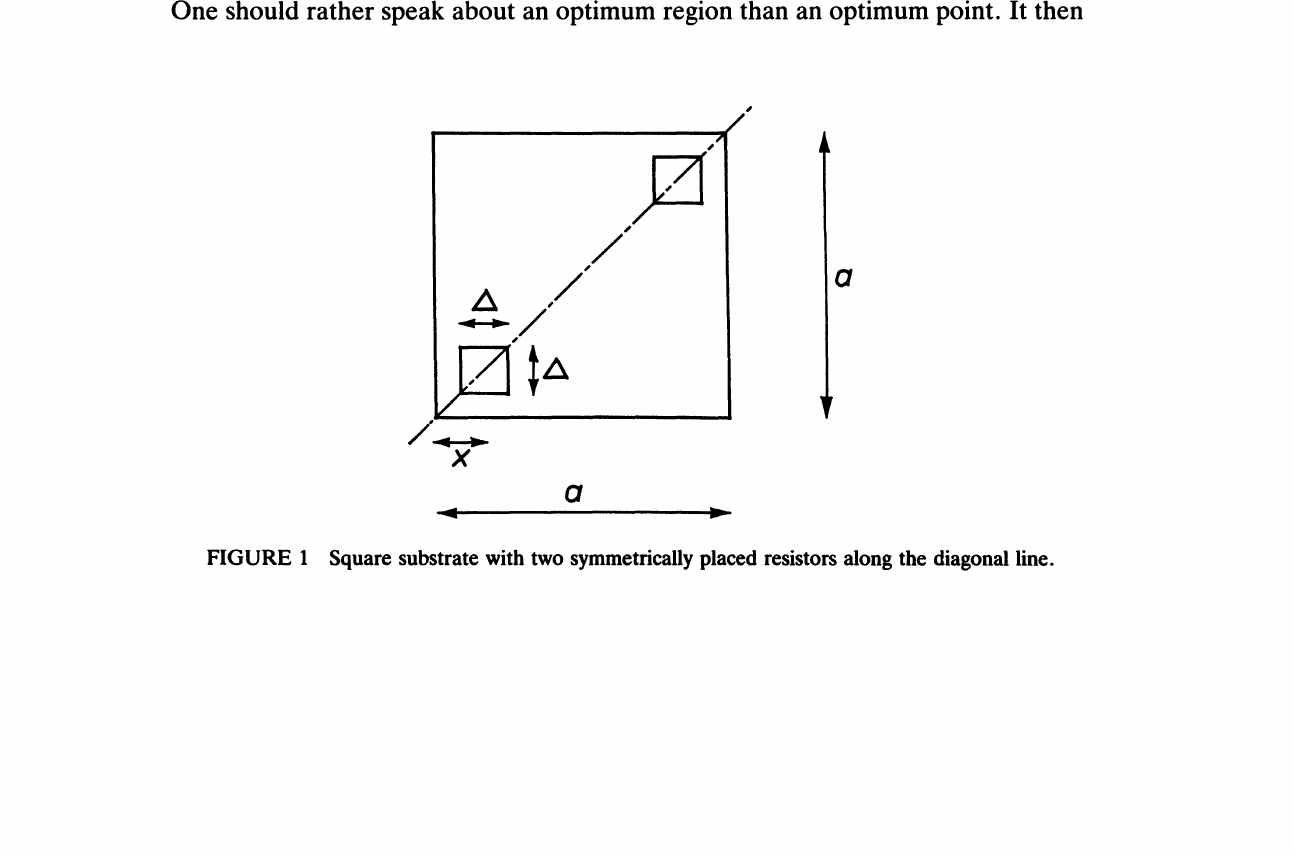
FIGURE Square substrate with two symmetrically placed resistors along the diagonal